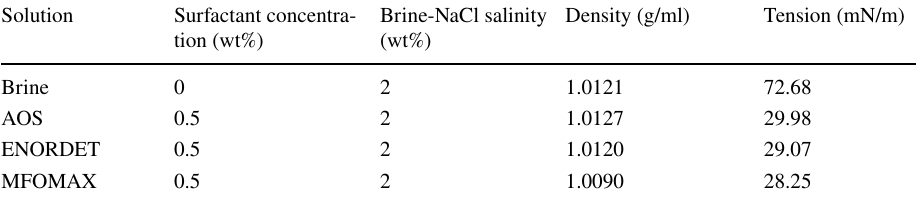
Table 4 Surfactant solution characterization in term of its concentration and brine salinity